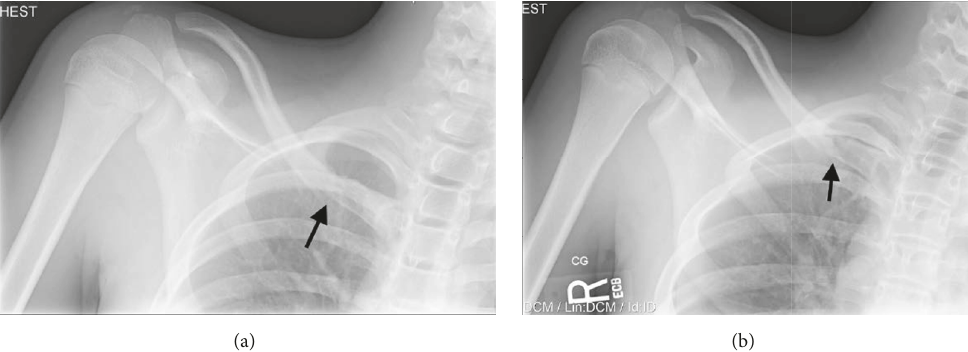
Figure 1: (a) Preoperative AP view and (b) AP cephalic tilt view of the right medial clavicle. The black arrow indicates the site of fracture.